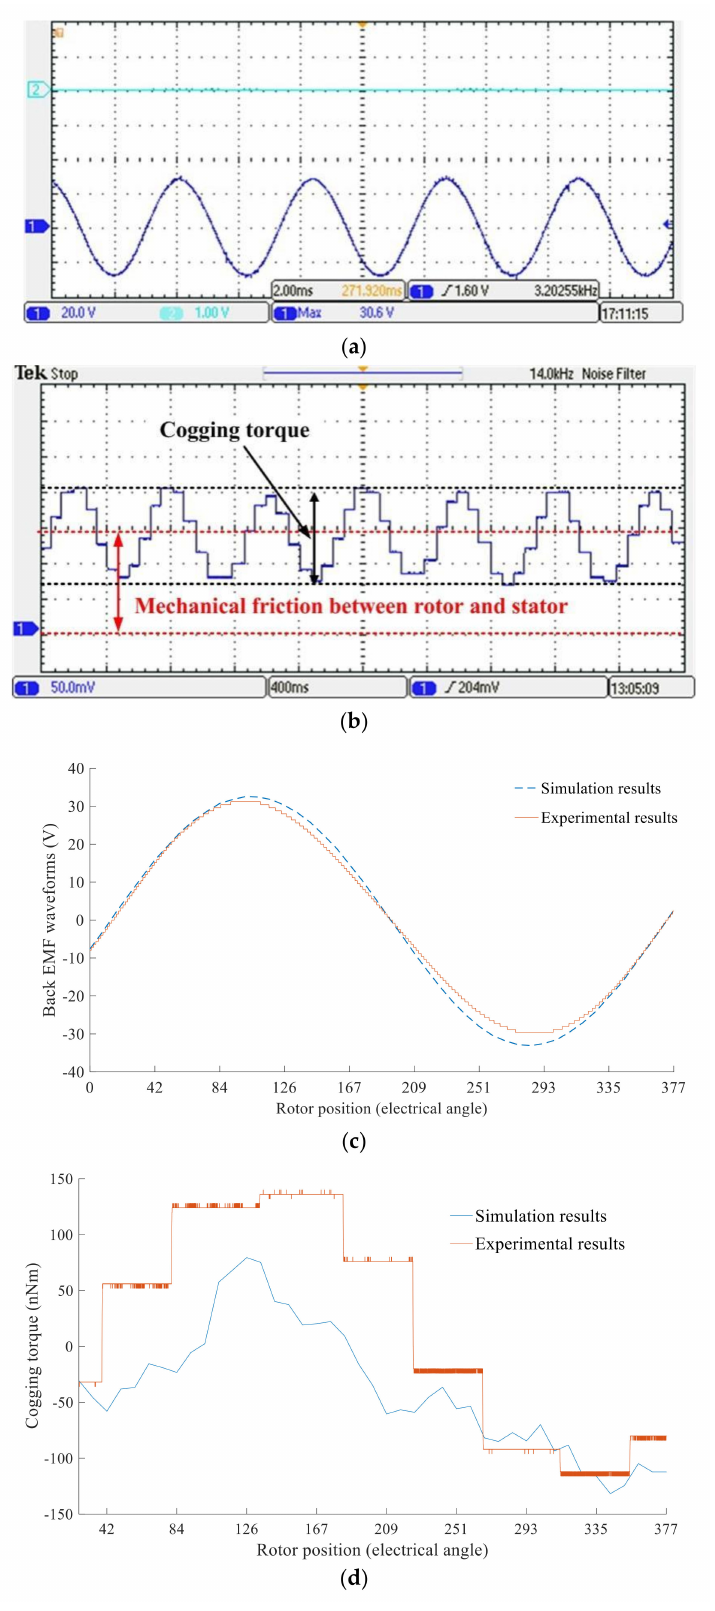
Figure 9. The experimental and comparison results of the VFMPM machine in enhanced flux condition. ( a ) Experimental results of back EMF waveforms; ( b ) Experimental results of cogging torque; ( c ) Comparison of back EMF waveforms; ( d ) Comparison of cogging